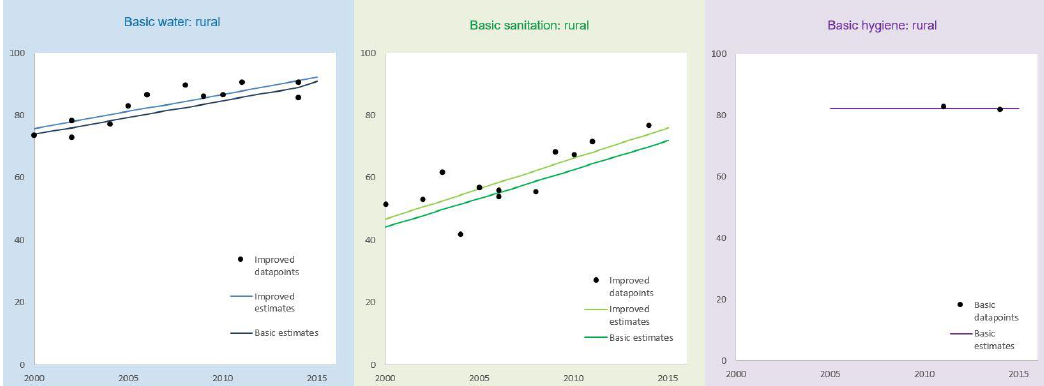
Figure 1. Example of JMP linear regression method using rural Viet Nam data: ( a ) Drinking water ( b ) sanitation and ( c ) hygiene. Source: WHO/UNICEF JMP